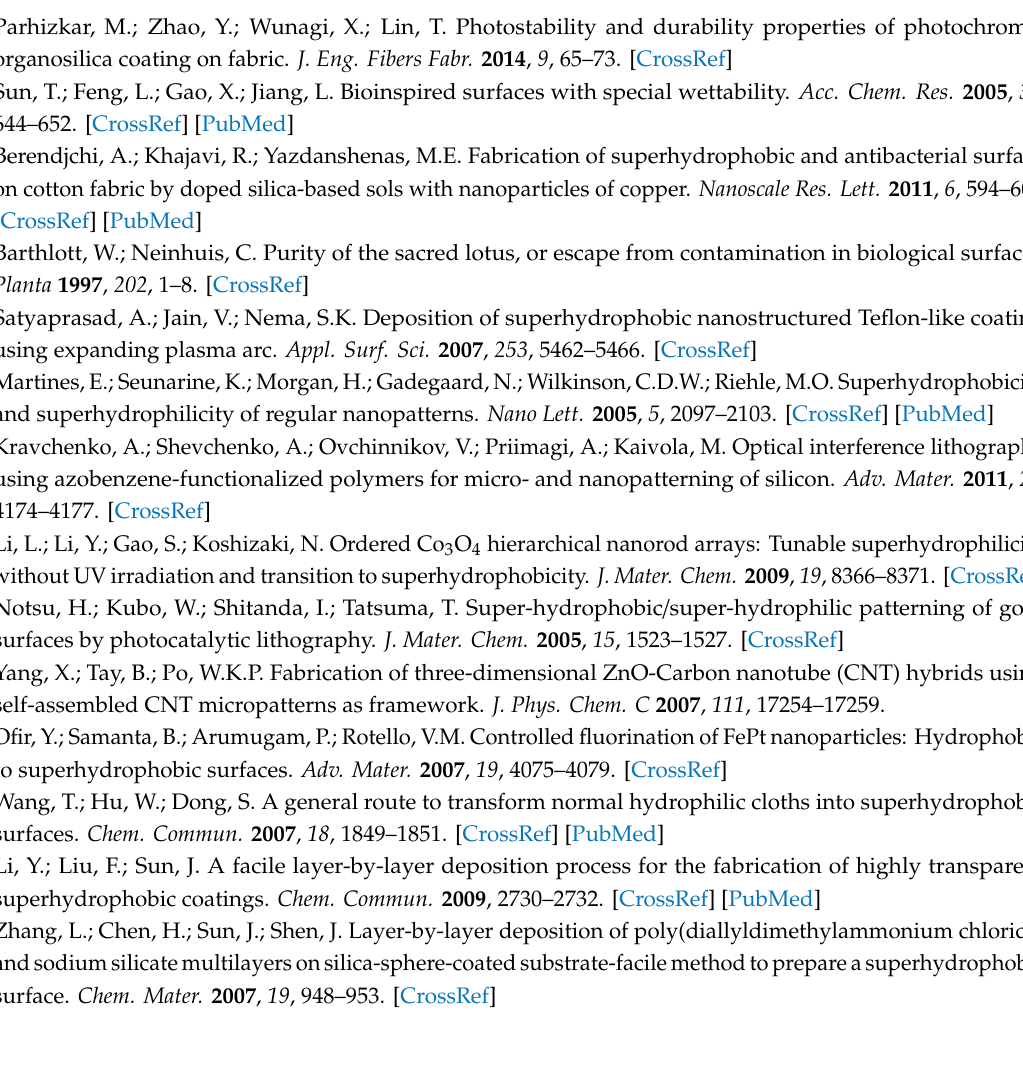
Table S1: TGA and DTG data. Figure S1: Surface for height of small structure. Figure S2: SEM image of OmniBlock-coated cotton fabric. Figure S3: The optical images of water and n-dodecane droplets on the cotton fabric. Figure S4: Optical images of HD and GD droplets. Figure S5: Optical images of shedding angle analysis for n-dodecane. Figure S6: The optical images of knotted cotton